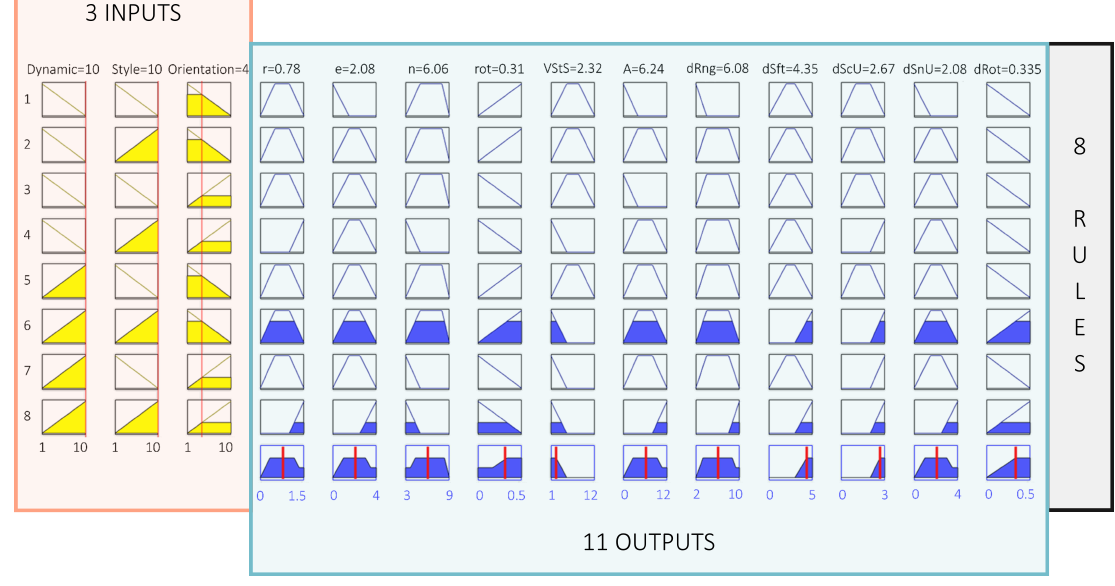
Figure 14. Fuzzy rules in EmPatGen.